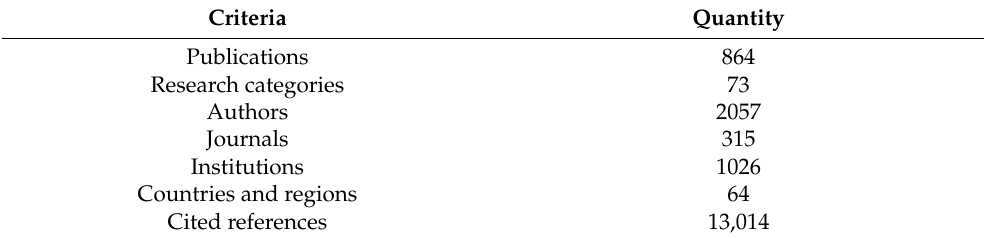
Table 3. Descriptive results.